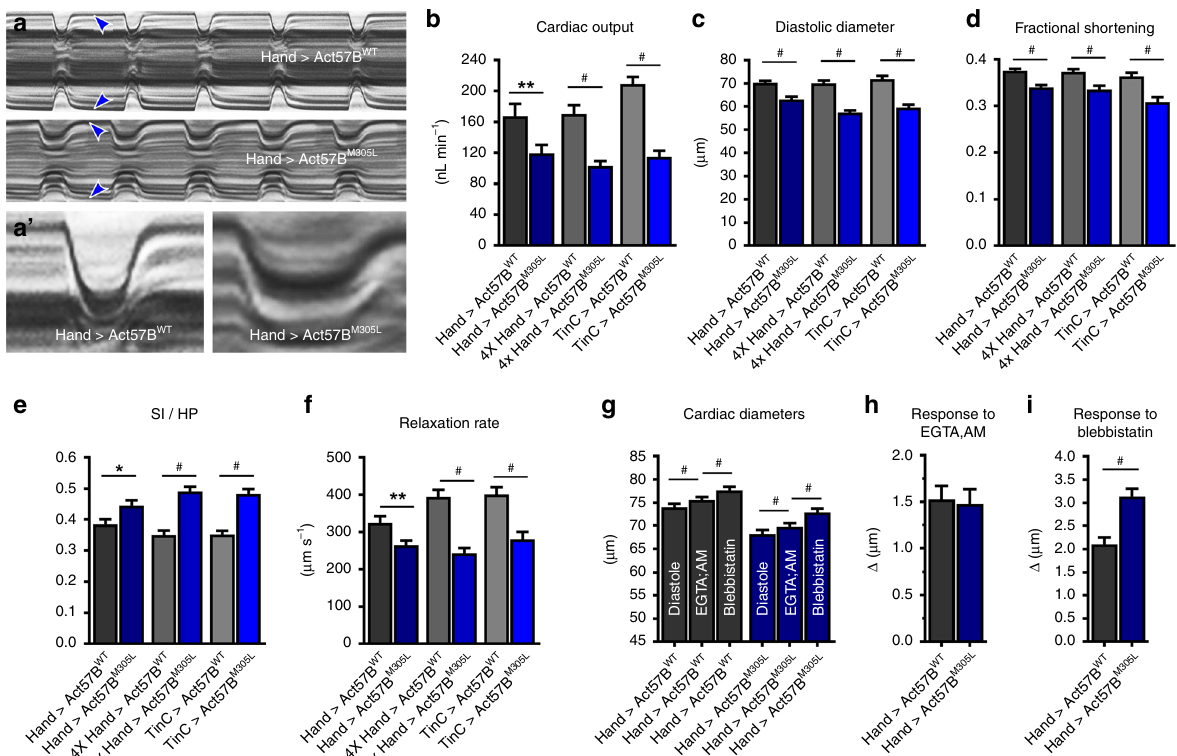
Fig. 2 M305L actin triggers restrictive cardiac physiology and impairs relaxation. a M-mode kymograms generated from high-speed videos of beating, three-week-old Hand > Act57B WT and Hand > Act57B M305L hearts. These traces illustrate cardiac cycle dynamics and heart wall motion over time.